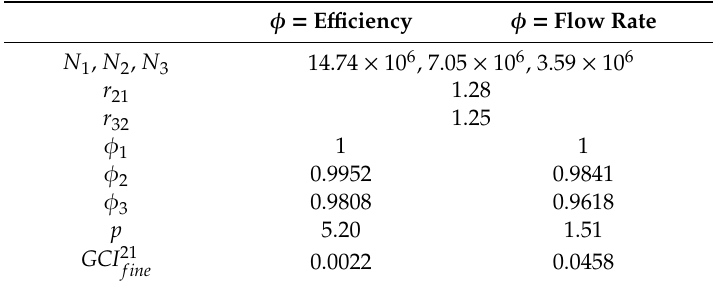
Table 2. Calculation of discretization error for the Francis turbine model.